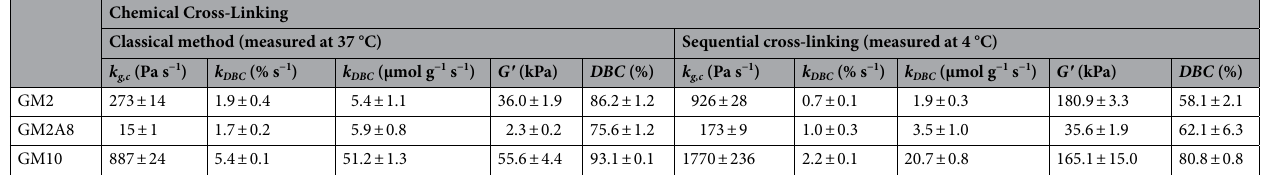
Table 3. Parameters describing the photo-induced chemical cross-linking of gelatin derivative solutions with the classical method at 37 °C or with the sequential cross-linking method: initial increases k g,c and k DBC of storage modulus G ′ and double bond conversion DBC , respectively, chemical gelation delay time t d,c upon UV irradiation, final G ′ , and final DBC . The data given in % are relative to the degree of methacryloylation (DM) of the respective gelatin